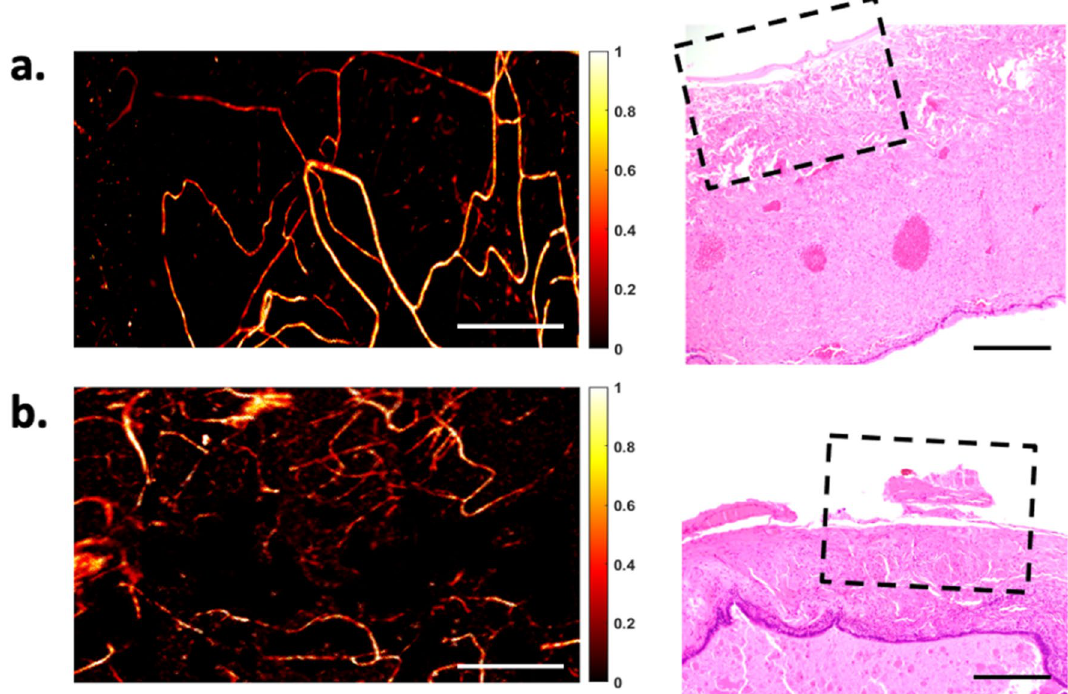
Figure 5. Two different types of benign ovarian lesions and their respective H&E histological images. ( a ) ovary with mucinous cystadenoma, and ( b ) ovary with cystadenofibroma. Scale bar: 500 μm.